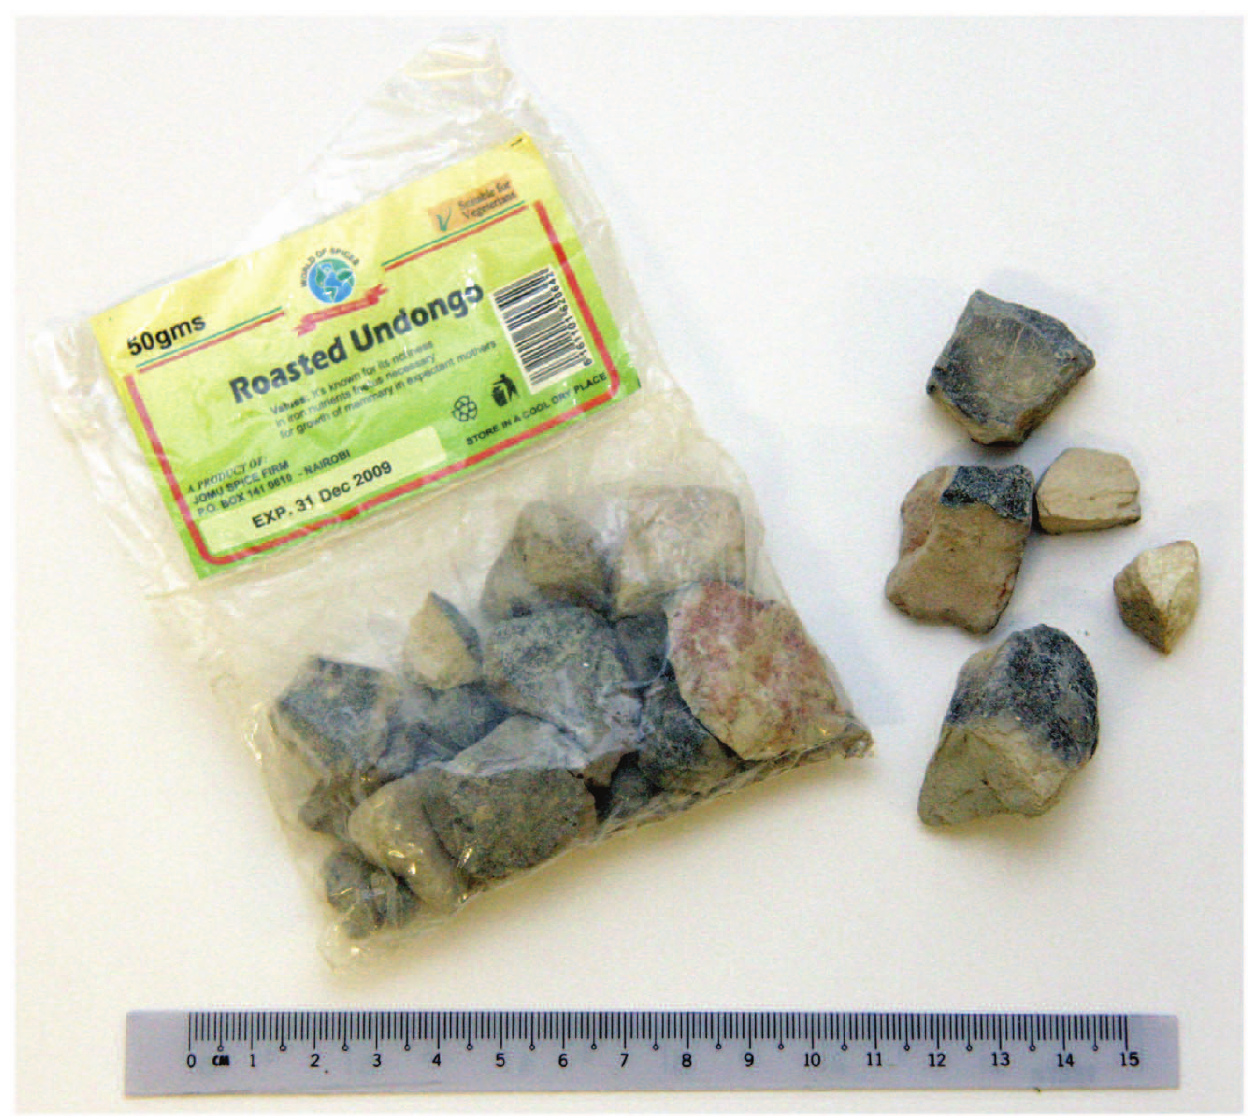
Figure 1. Roasted Undongo purchased from a small supermarket in Kenya. The labelling, not fully distinct on the image, states a ‘‘richness of iron’’ that is of benefit to pregnant women and their unborn child. Photograph: Peter W. Abrahams.